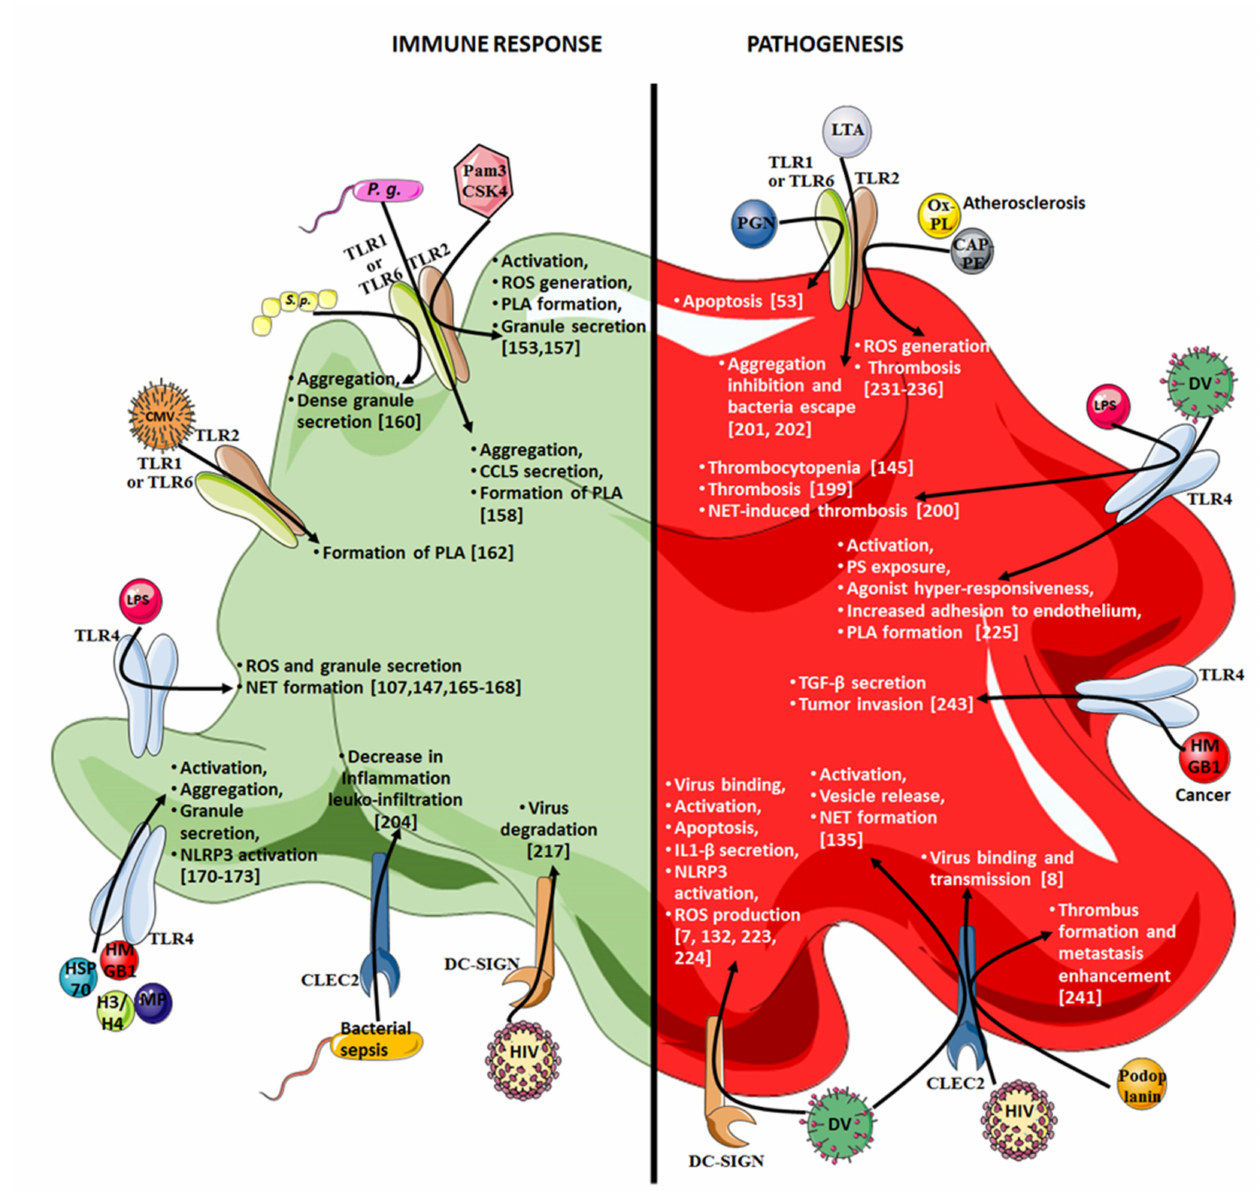
Figure 2. Platelet membrane innate immunity and toll-like receptors involved in the immune response and pathogene- sis. CAP-PE: carboxyalkylpyrrole-phosphatidylethanolamine, CLEC2: C-type lectin-like receptor 2, DC-SIGN: dendritic cell-specific intercellular adhesion molecule-3–grabbing nonintegrin, DV: dengue virus, H3/H4: H3 and H4 histone, HIV: human immunodeficiency virus, HMGB1: high-mobility group box 1, HSP: heat shock protein, IL: interleukine, LPS: lipopolysaccharide, LTA: lipoteichoic acid, MP: microparticle, NET: neutrophil extracellular trap, Ox-PL: oxidized phospho- lipid, P.g.: porphyromonas gingivalis, PGN: peptidoglycan, PLA: platelet-leukocyte aggregate, PS: phospatidylserine, ROS: reactive oxygen species, TLR: toll-like